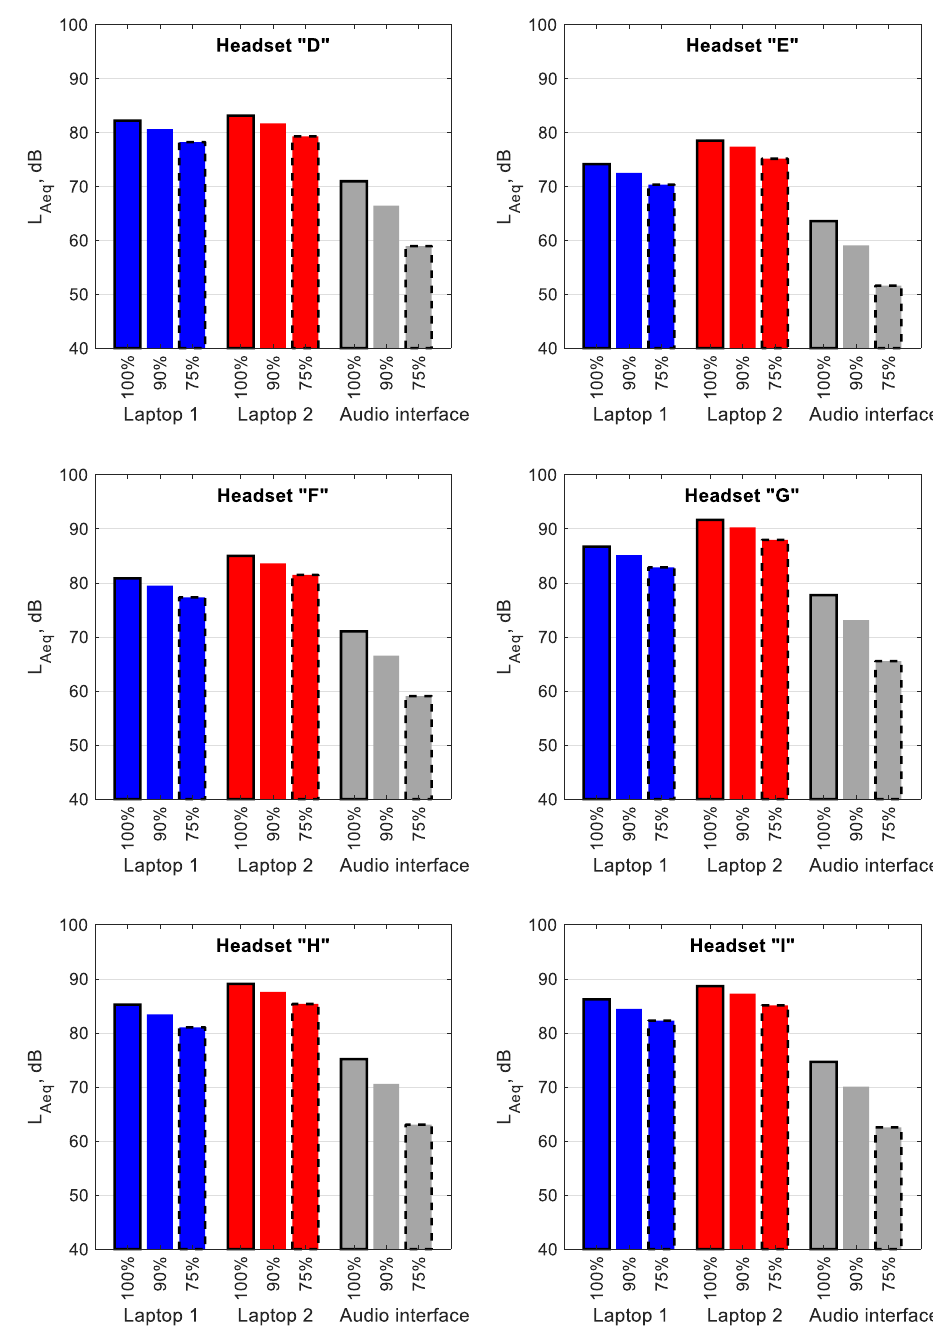
Figure 3. The values of A-weighted equivalent sound pressure level of the test signal reproduced by headsets connected to Laptop 1 and Laptop 2 as well as by headsets connected to Laptop 1 through a mobile audio interface using a 3.5 mm-jack connector. The values given as percentages indicate the control level values of the test signal.